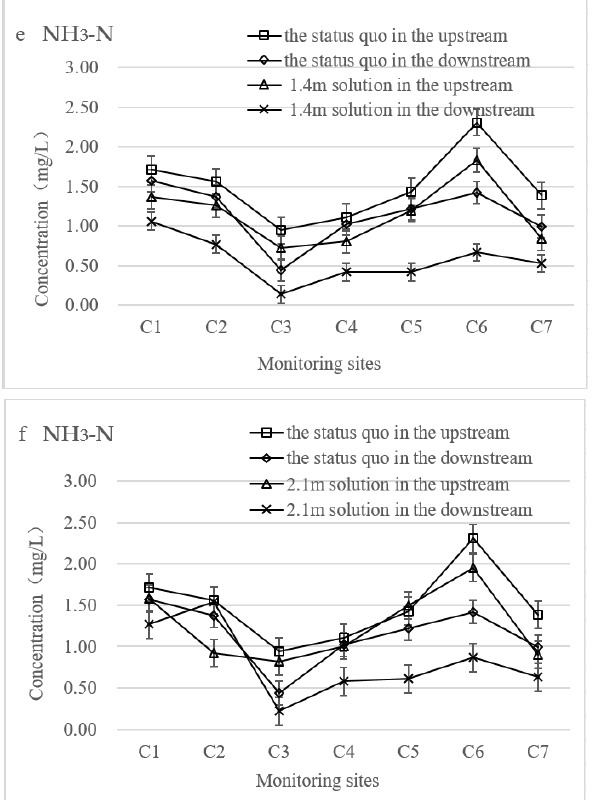
Figure 5. The changes in COD Mn and NH 3 -N concentrations under different floodgate operations. ( a ) COD Mn concentration changes under 0.7m solution; ( b ) COD Mn concentration changes under 1.4m solution; ( c ) COD Mn concentration changes under 2.1m solution; ( d ) NH 3 -N concentration changes under 0.7m solution; ( e ) NH 3 -N concentration changes under 1.4m solution; ( f ) NH 3